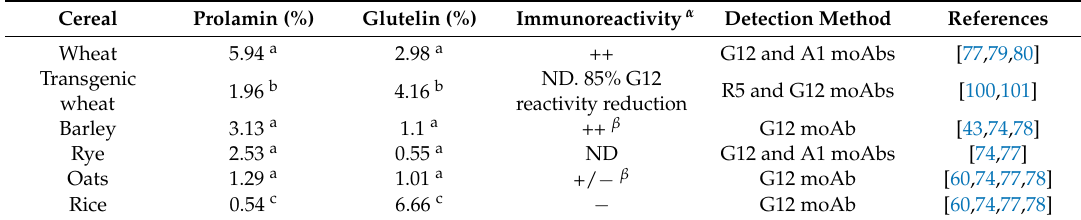
Table 3. Prolamin and glutelin content of cereals and their immunoreactivity in vitro.